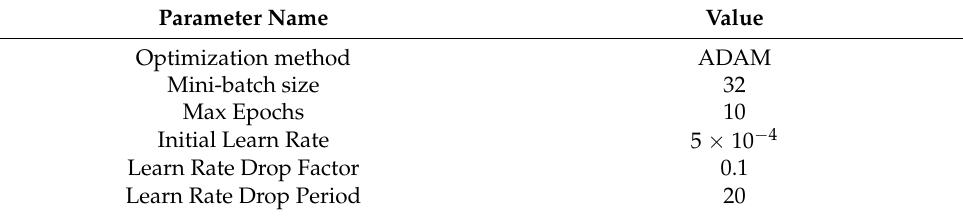
Table 5. Model training parameters